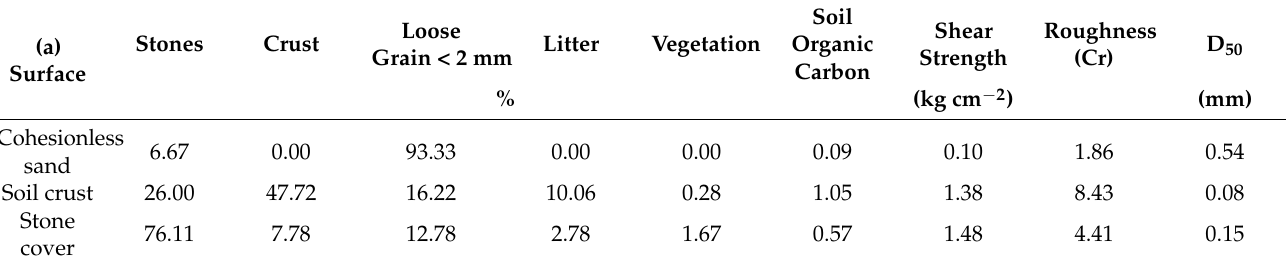
Table 2. Mean characteristics of surface